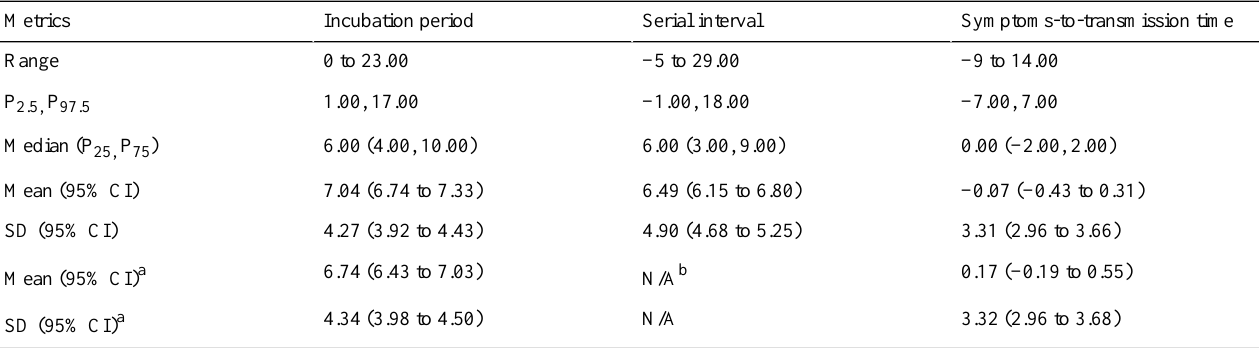
Table 2. The estimates of incubation period, serial interval, and symptoms-to-transmission time (unit: day).